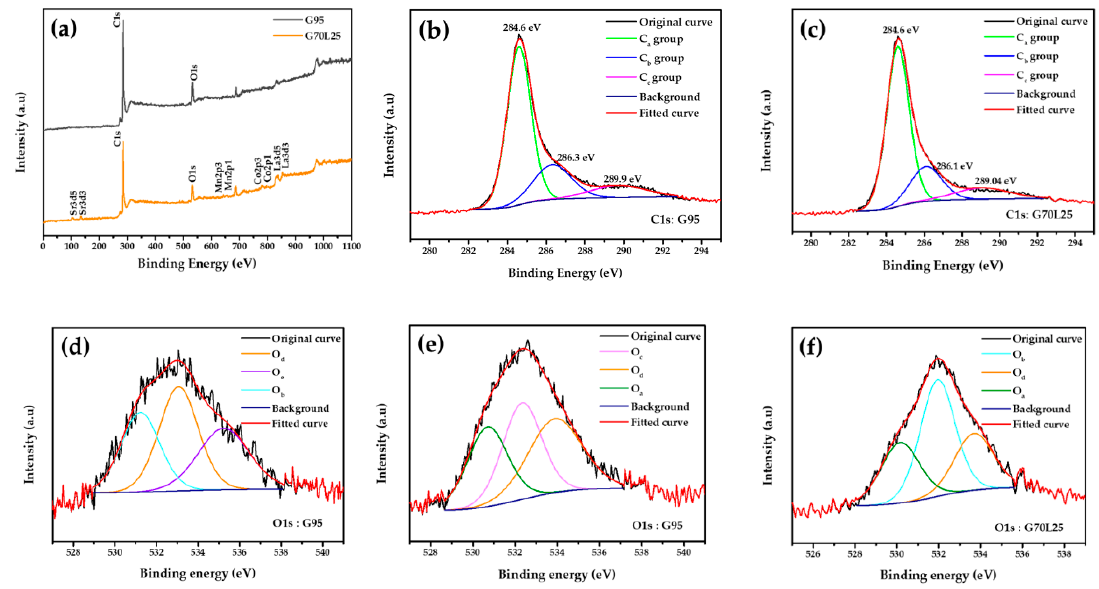
Figure 4. ( a ) XPS fully scanned spectrum of G95 and G70L25; fitted results of XPS C1s spectra of ( b ) G95 and ( c ) G70L25; fitted results of XPS O1s spectra of ( d , e ) G95 and ( f ) G70L25.